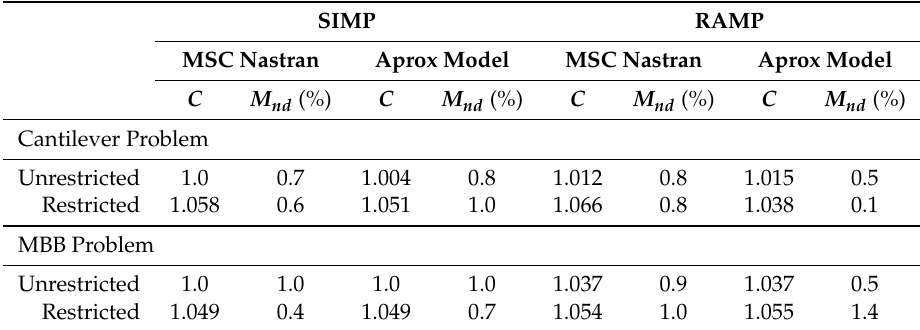
Figure 5. Topology optimization of the MBB problem at Iterations 20, 90, 150, and 300. In each subfigure, the left image uses full precision structural equilibrium, and the right image uses approximate structural equilibrium. Table 1. Overview of the topology optimization of the cantilever and MBB problems at Iteration 300 in terms of Compliance (C) and the measure of non-discreteness level ( M nd